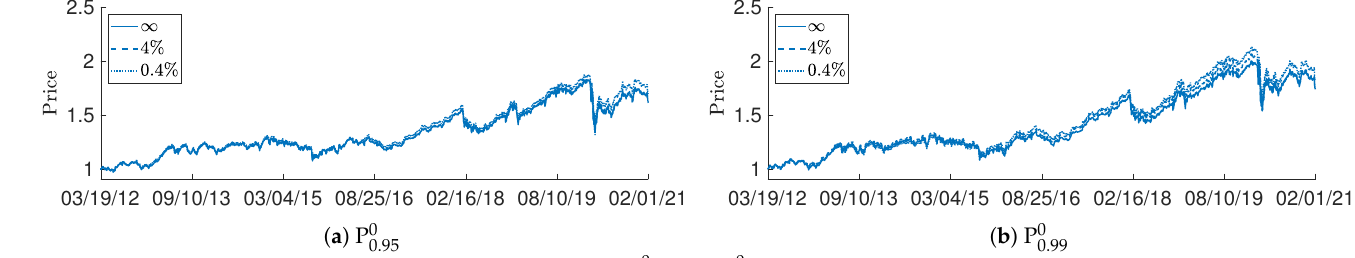
Figure 2. Cumulative price performance of the P 0